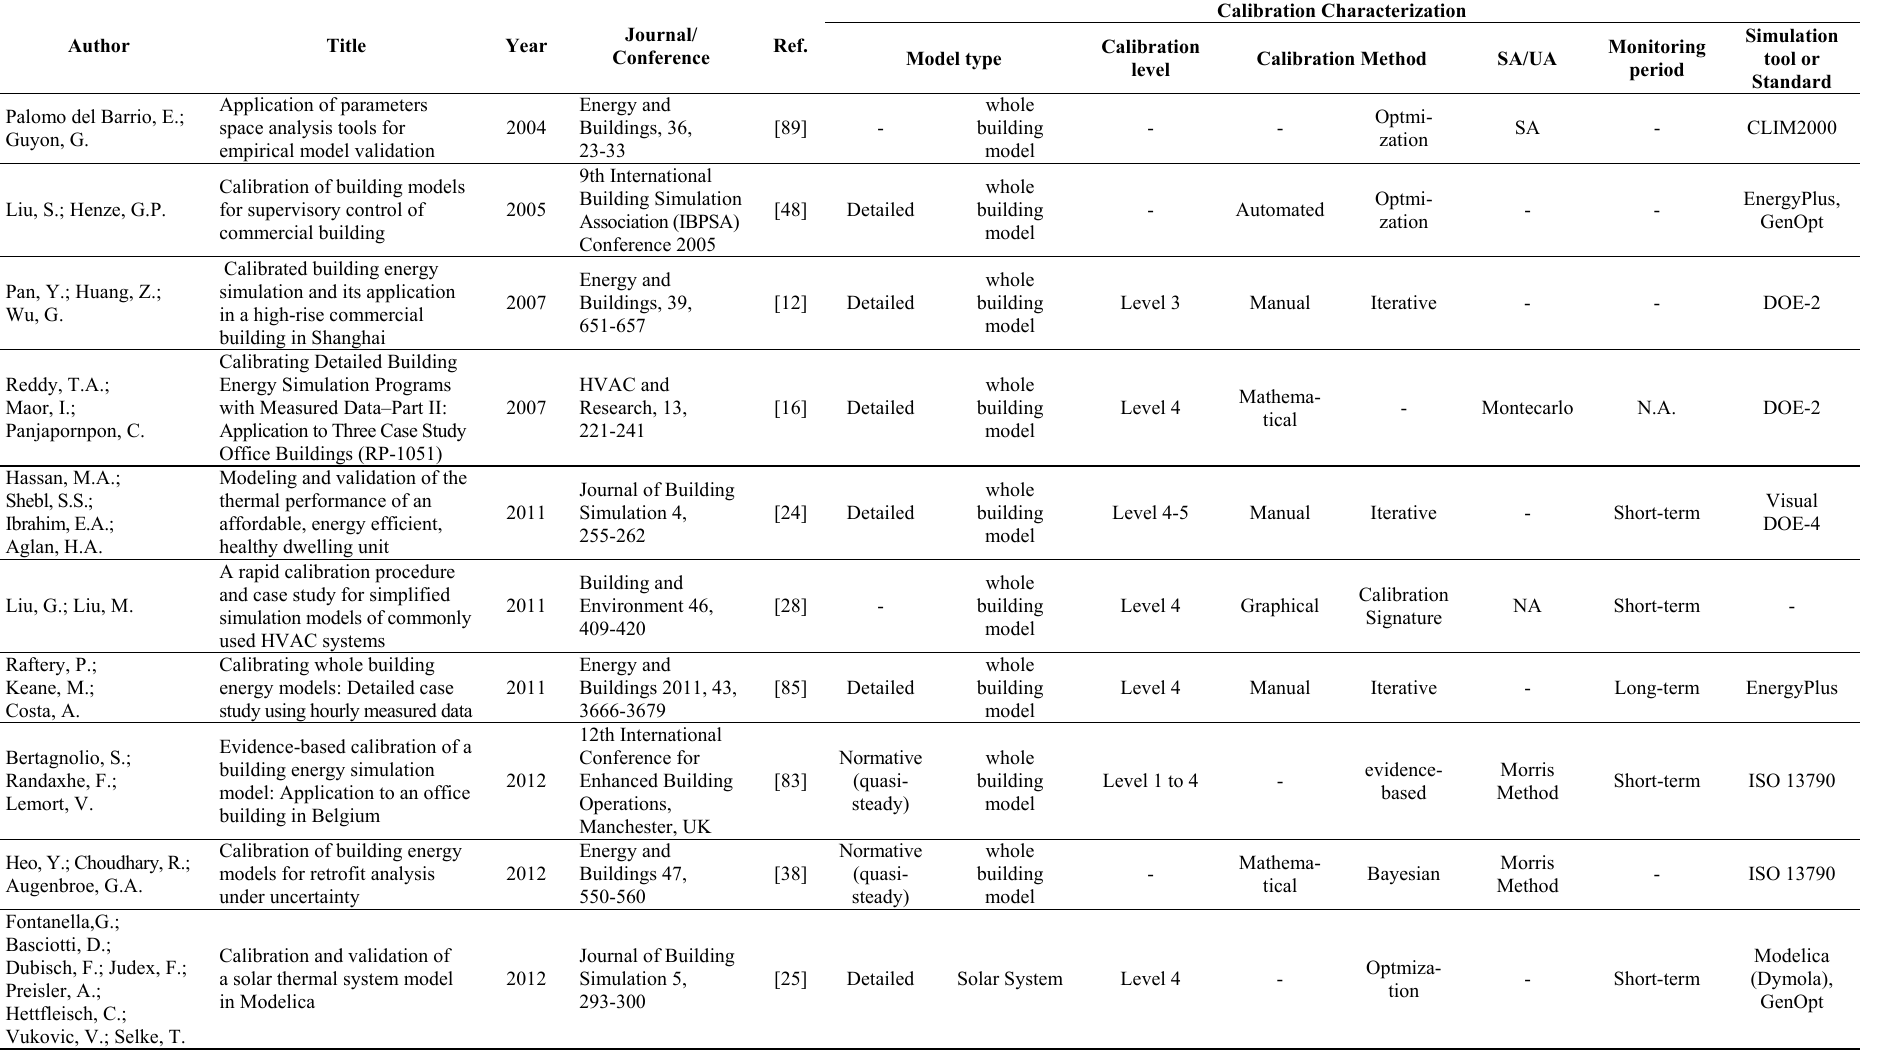
Table 4. List of the most recent published application CS in the domain of building